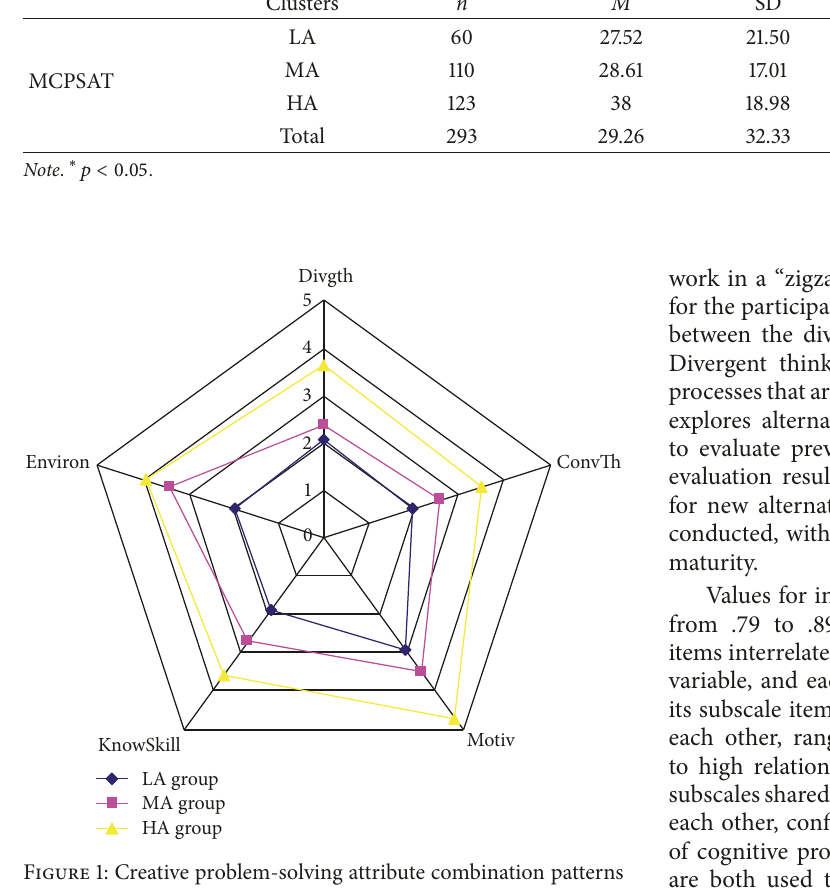
Figure 1: Creative problem-solving attribute combination patterns for HA, MA, and LA